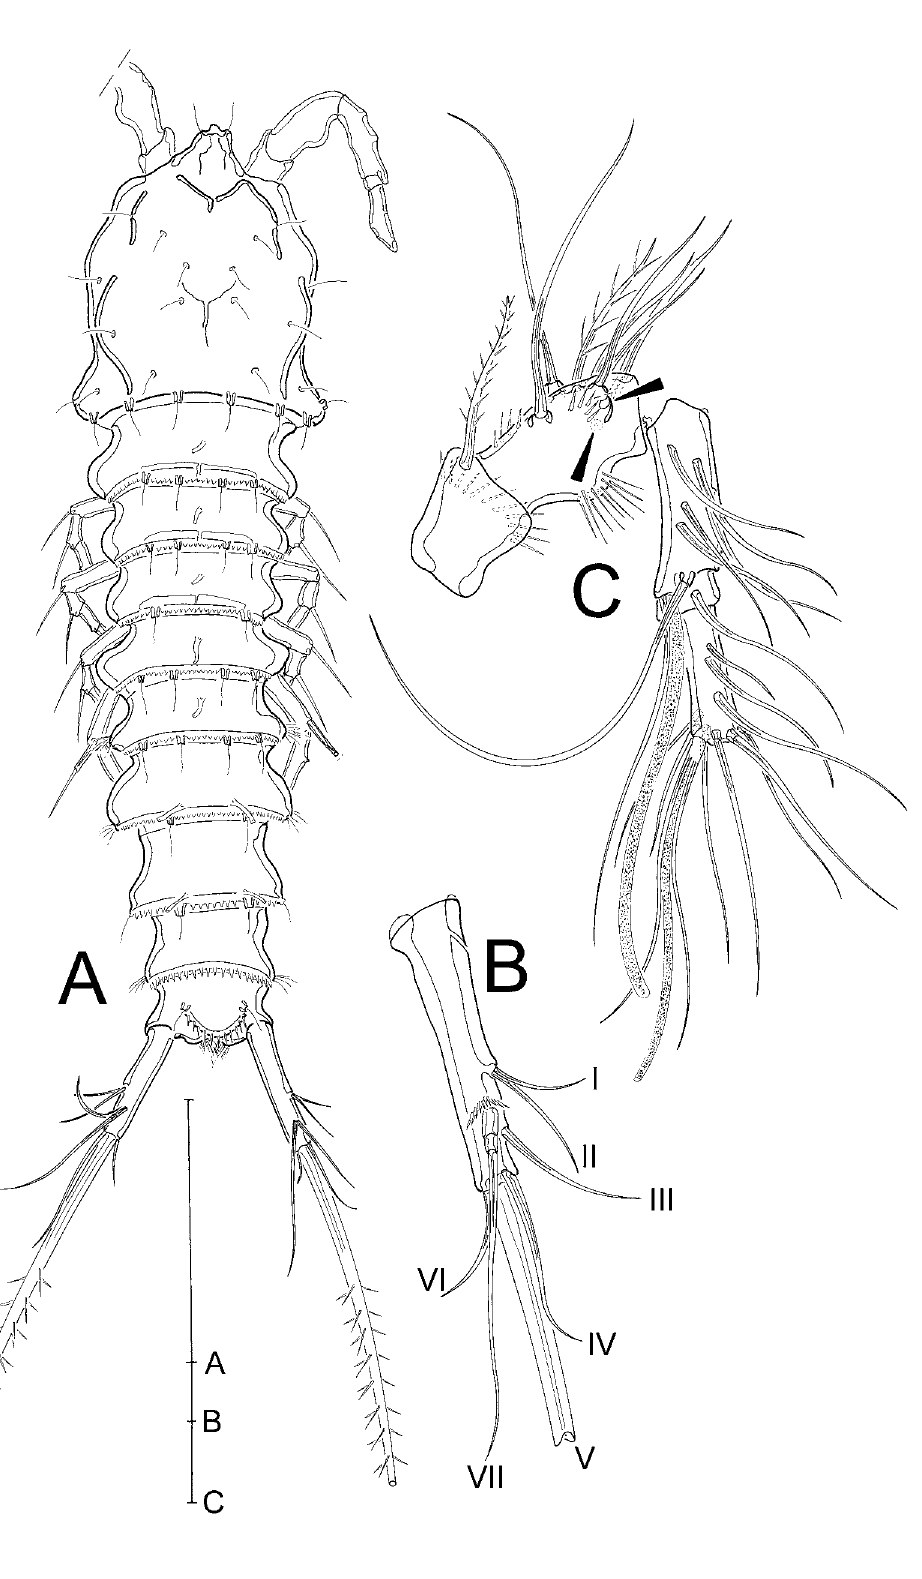
Fig. 9. Laophontodes sarsi sp. nov. A–B . Holotype, ♀ (NHM F20298-1). A . Habitus, dorsal view. B . right furcal ramus, dorsal view. C . Paratype, ♀ (NHM F20298-2), A1, triangular arrowheads marking broken setae. Scale bar: A = 100 µm, B–C = 50